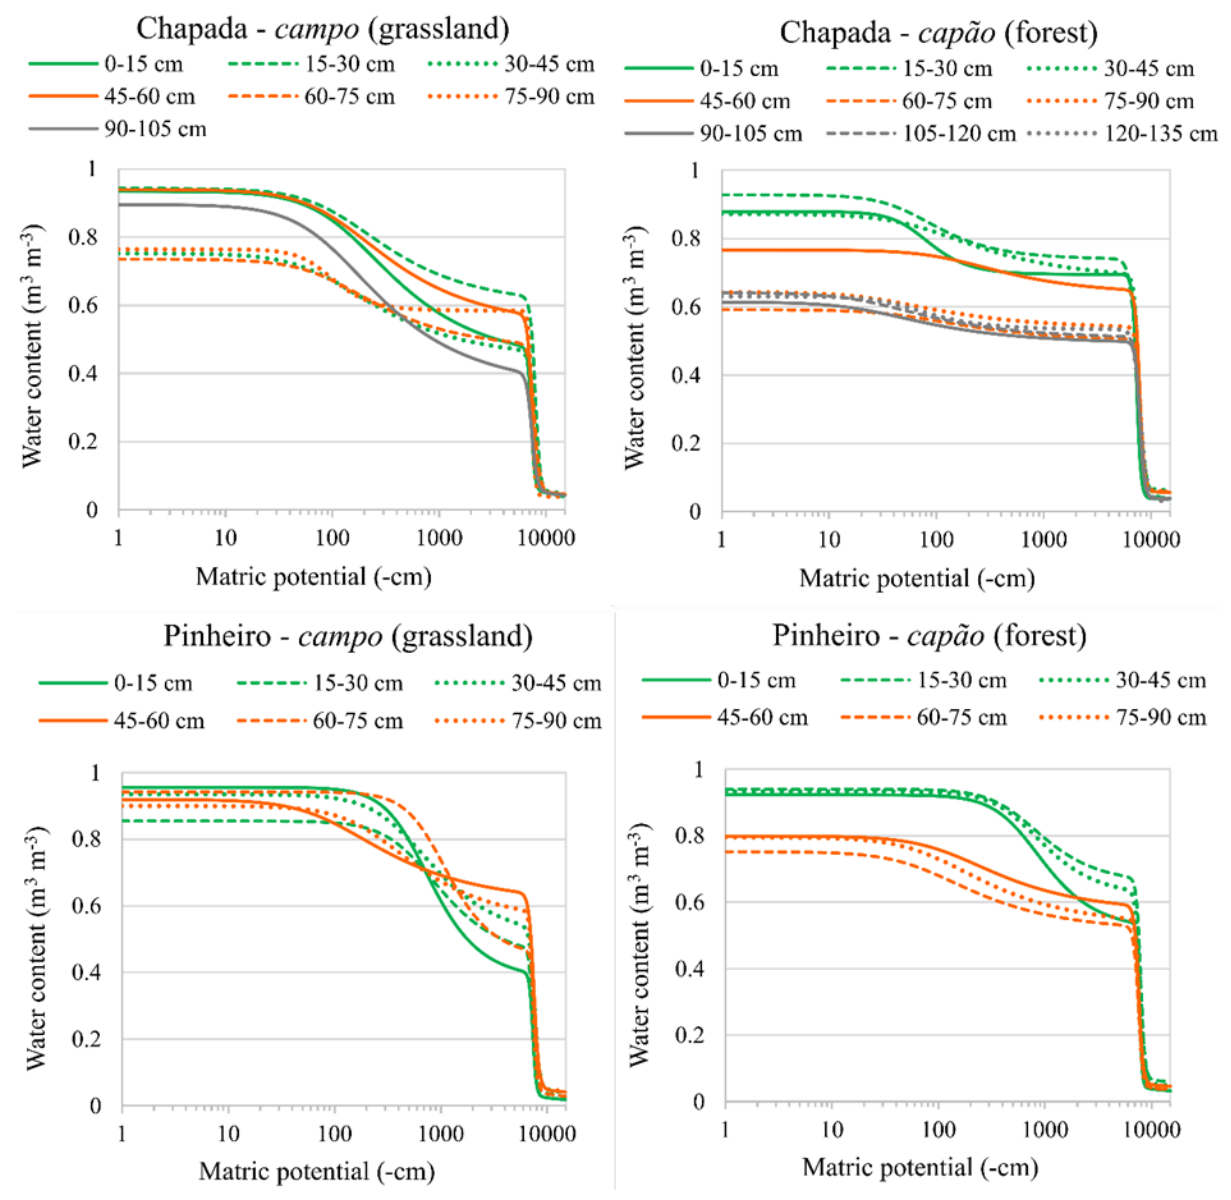
Figure 6. Bimodal water retention curves for the evaluated layers from both peatlands (Chapada and Pinheiro) under forest and grassland vegetation ( campo and capão ,